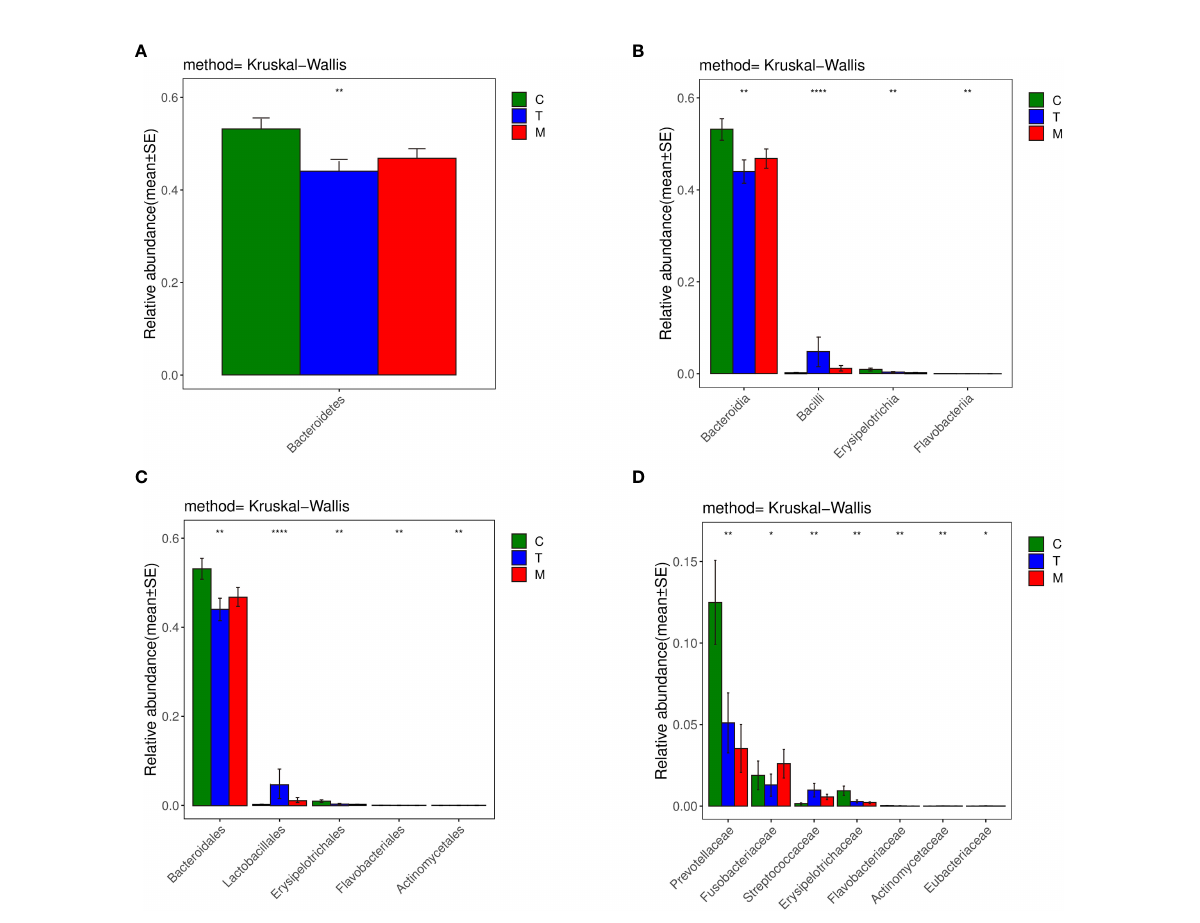
FIGURE 6 Histograms of differences in the diversity of species analyzed by kruskal_ Wilcox test among three groups at the levels of phylum (A) , class (B) , order (C) , family (D) , genus. *p < 0.05, **p < 0.01, ***p < 0.001, ****p <